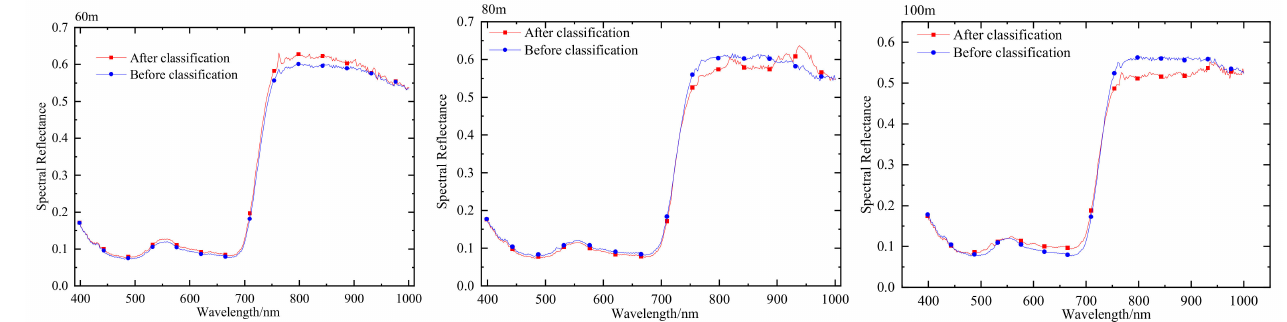
Figure 8. Hyperspectral reflectance before and after pixel classification of the UAV image.